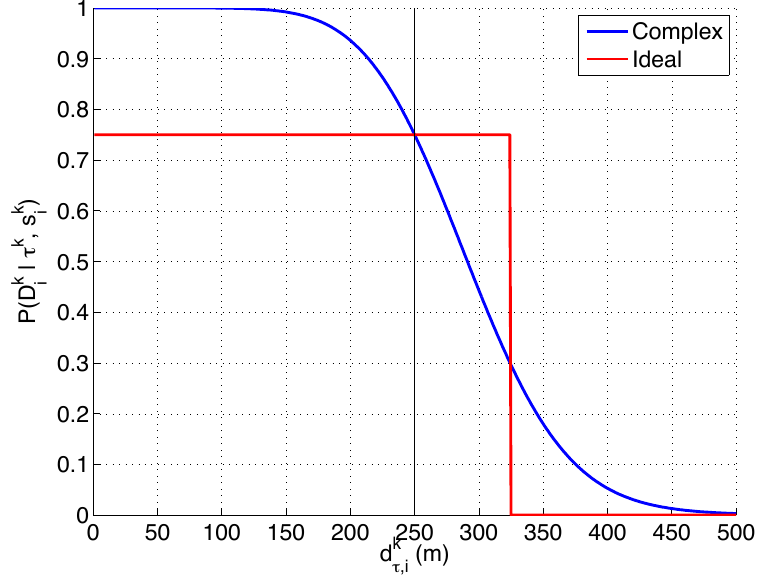
Figure 2. Radar detection probability curves, with the first complex model in blue and = 10 − 6 , C = 1 . 126 × 10 11 (obtained to make the second ideal model in red, when P fa (cid:15) P ( z k = D | τ k , s k , (cid:15) ) = 0 . 75 at d k = h = 250 m), P = 0 . 75 and δ = 325 m. With d i i τ,i UAVs flying at h = 250 m, the probability values used in the experiments are placed after the vertical black